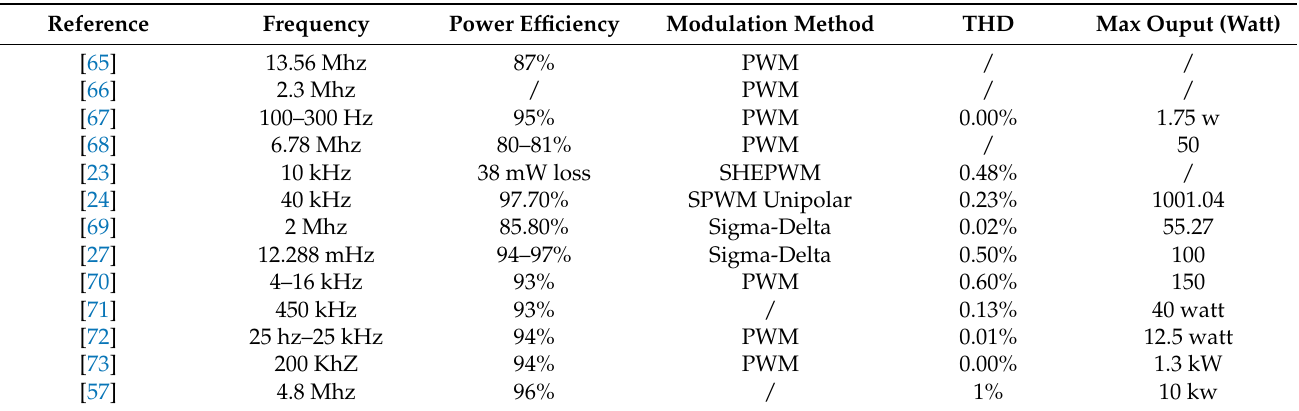
Table 2. The parameters of GaN Class D Amplifier.